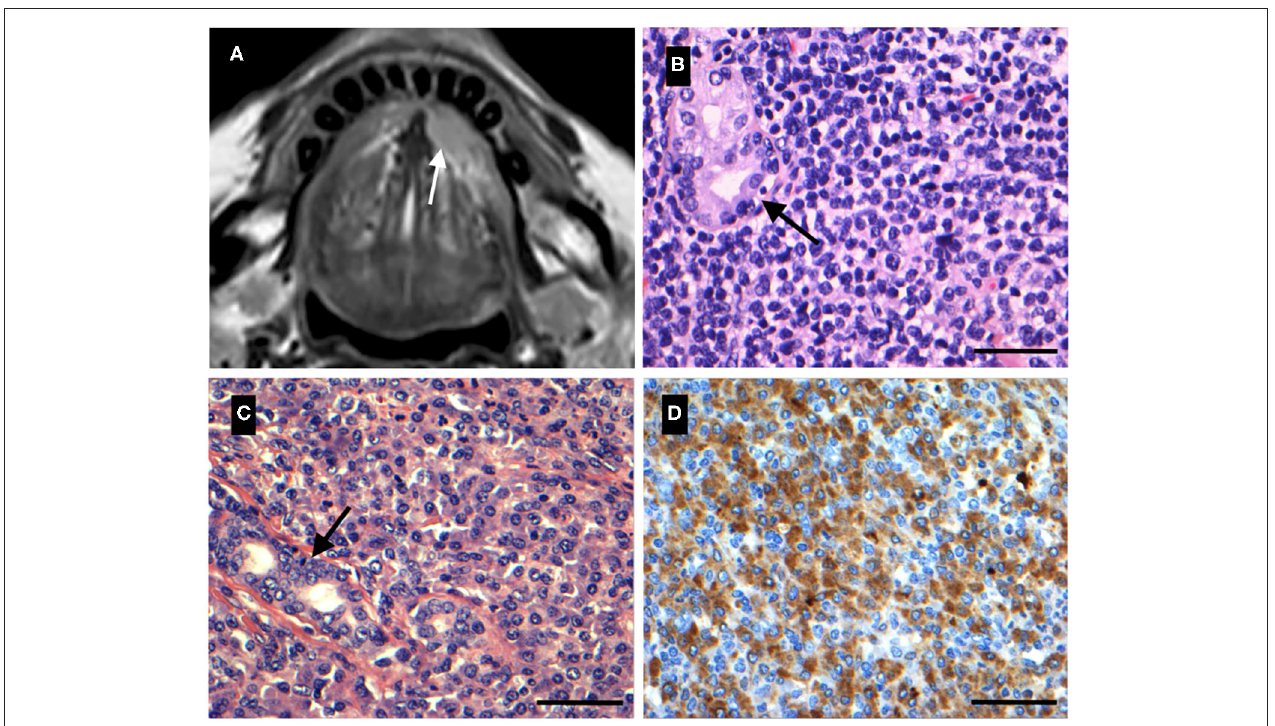
FIGURE 1 | (A) A 68-year-old female with relapse of known Mantle cell lymphoma (MCL) resulting in swelling of the left sublingual gland. Magnetic resonance imaging (MRI) showing a tumor of the left sublingual gland (white arrow). (B) Histological image of the sublingual gland MCL (A) . Salivary gland tissue is infiltrated by lymphoid tumor tissue and small tumor cells are seen with multiple membrane bound nucleoli. Ductal structures are seen (black arrow) (HE). (C) A 61-year-old male with 1-month history of painless swelling of the floor of the mouth. Tumor tissue was composed of neoplastic lymphoid cells with irregular nuclei and plasmacytic differentiation, consistent with a diagnosis of extranodal marginal zone lymphoma (EMZL) of the left sublingual gland. Scattered ductal structures are seen (black arrow) (HE). (D) Immunohistochemistry of the sublingual gland EMZL (C) showing positive reaction for lambda light chain. Scale bar = 50 µ